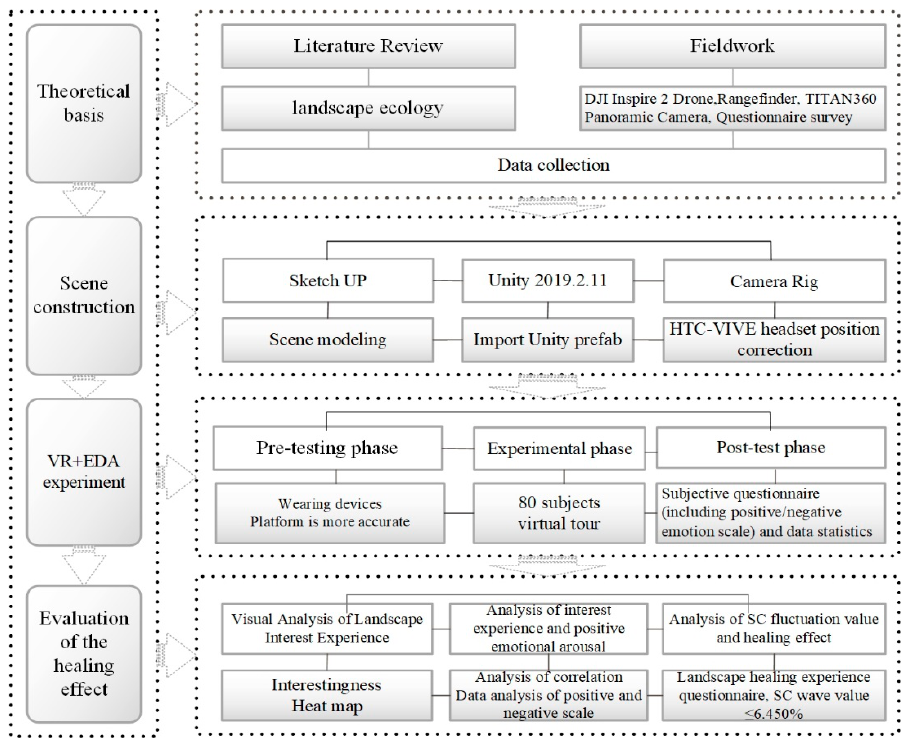
Figure 5. Research framework diagram.